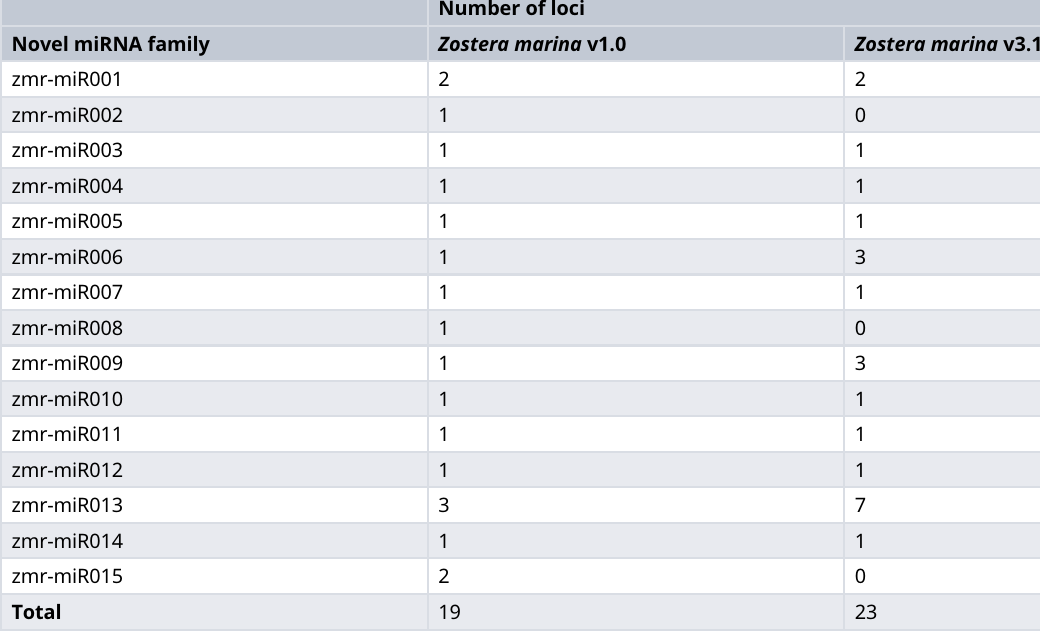
Table 4. Novel miRNA candidates in Zostera marina (v1.0 and